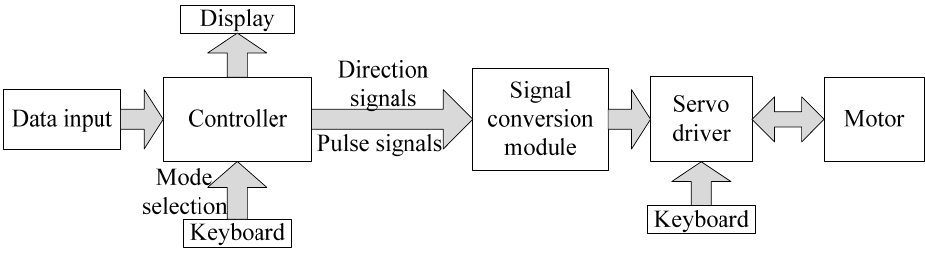
Figure 9. Hardware framework of the stepping machine.